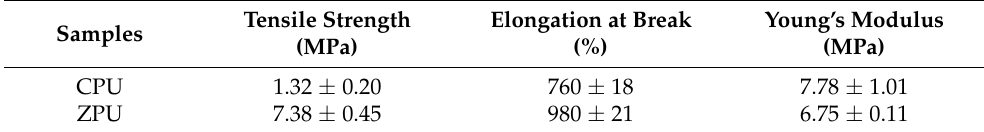
Figure 6. Continuous cyclic tensile curves of ZPU ( a ) At various strains without relaxing, ( b ) At 200% strain without relaxing and then relaxing for 30 min.